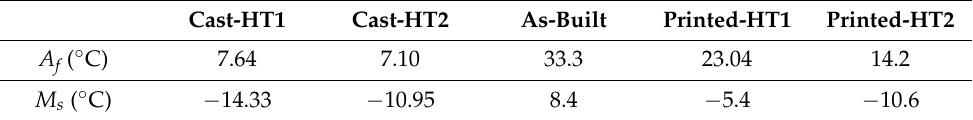
Figure 4. DSC curves for four heat-treated samples in the cast and printed conditions along with the powder and as-built sample. Table 3. Transformation temperatures for different NiTi samples.